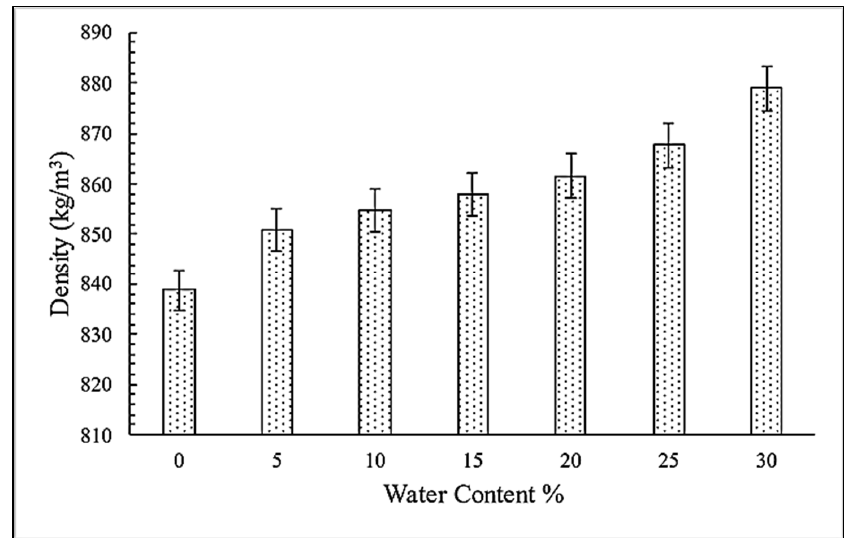
Figure 5. The density of different blends of the (W/D) fuel.